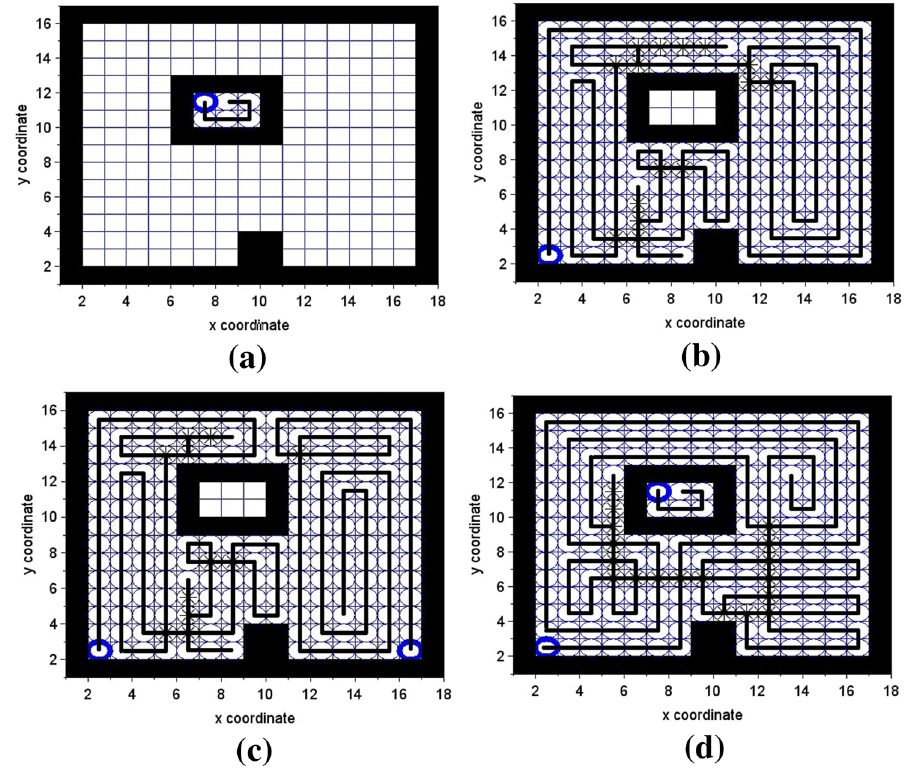
Fig. 6 a Failure of grid cover- age by a single mobile robot; b failure of grid coverage by a single mobile robot; c failure of grid coverage by two mobile robots; d successful grid cover- age by two mobile